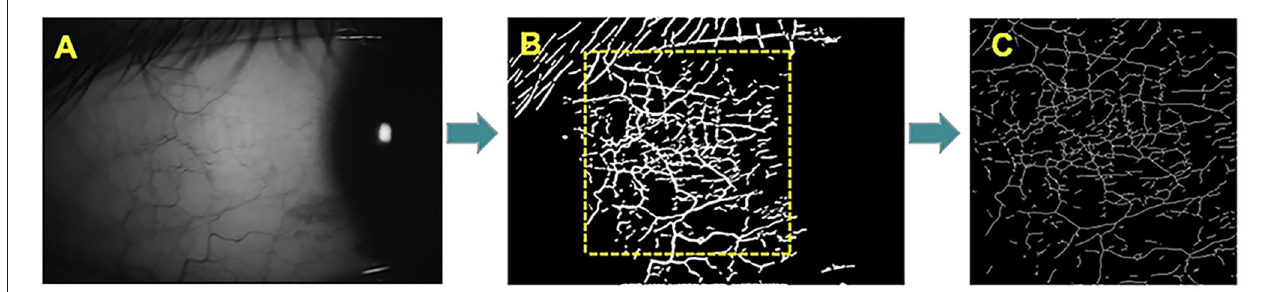
FIGURE 2 | The OCTA image of the temporal conjunctiva. The microvascular network was extract in a field of 3 × 3-mm and analysis by the software. (A) Images of the patient’s temporal conjunctiva. (B) OCTA scan of the temporal conjunctiva with microvascular density. (C) Microvascular density of 3 × 3 mm 2 in region of interest.